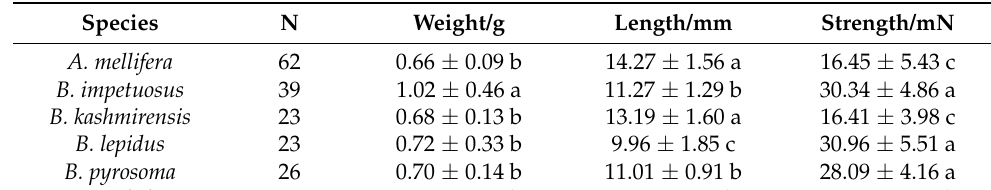
Table 2. The weight, length, and strength of visitors. B. impetuosus , B. lepidus , and B. pyrosoma are visitors of D. caeruleum . Means ± SD are shown. Different letters (a, b, and c) within the same column indicate significant difference at p < 0.05.